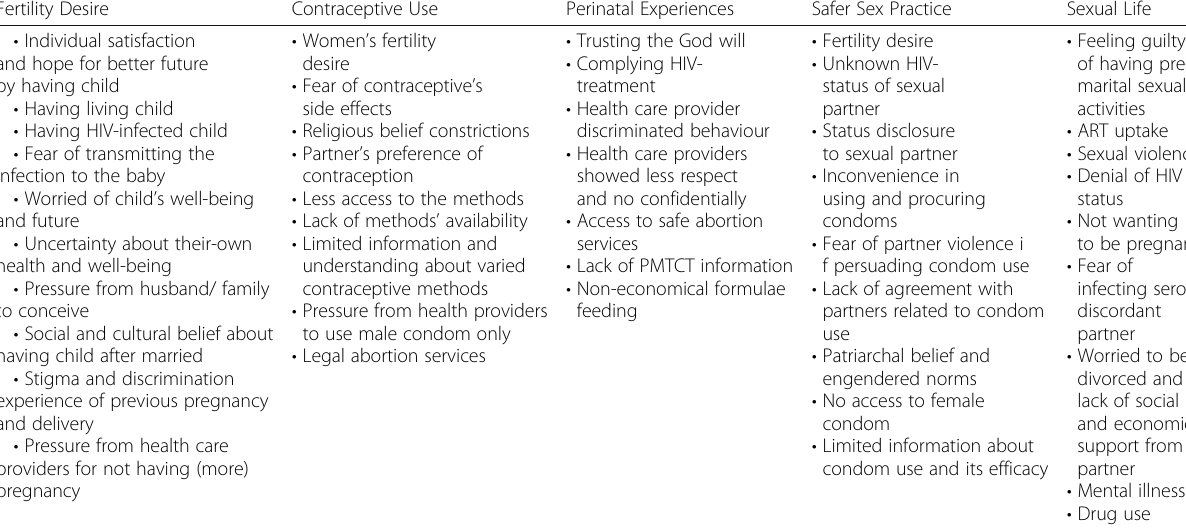
Table 4 Synthesis findings: factors influencing the sexual and reproductive health among WLHIV in Muslim-majority countries Fertility Desire Contraceptive Use Perinatal Experiences Safer Sex Practice Sexual